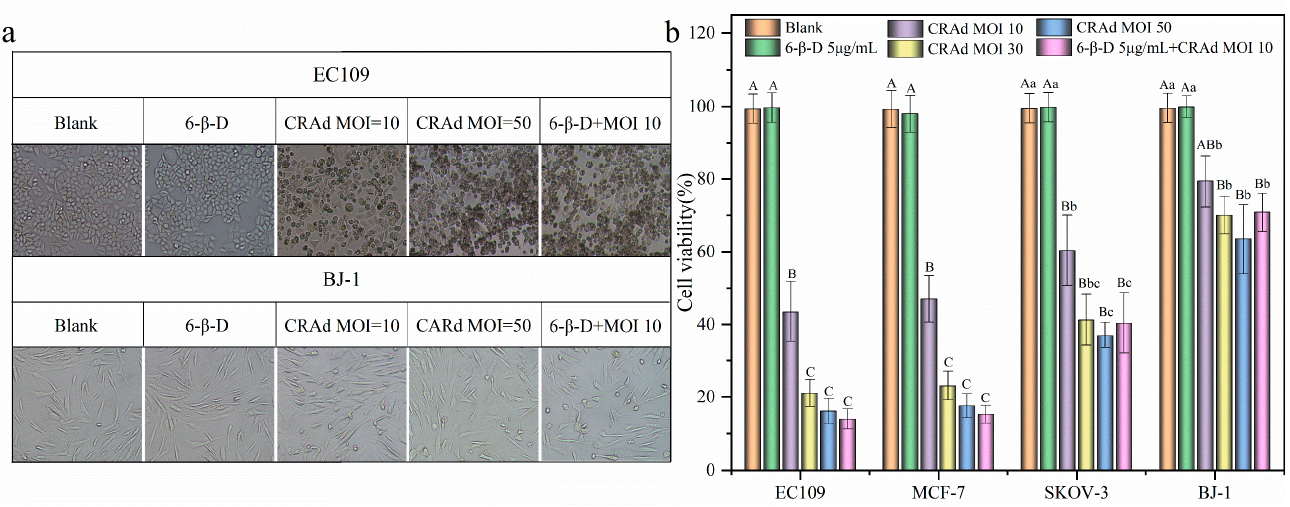
Figure 3. Application of 6- β -D improved the oncolytic effect of CRAd. ( a ) Comparison of cytopathic effects on esophageal cancer cells EC109 vs. human normal skin fibroblast cells BJ-1 after infection with different titers of CRAd (×200); ( b ) The synergistic killing effect of CRAd (MOI 10) + 6- β -D achieved outcomes of higher MOI 50 on various cancer cell lines. Note: Different letters indicate significant difference in pairwise comparison, while the same letter means no significant difference. The difference was significant in lowercase letters ( p < 0.05) and extremely significant in uppercase letters ( p < 0.01).